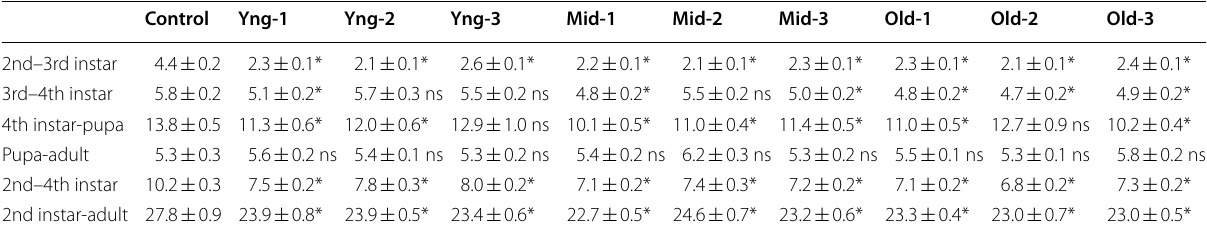
Asterisk in each row indicates a significant difference between the cannibal beetles and the control beetles ( p < 0.05), while ns means non-significant difference (p > 0.05)